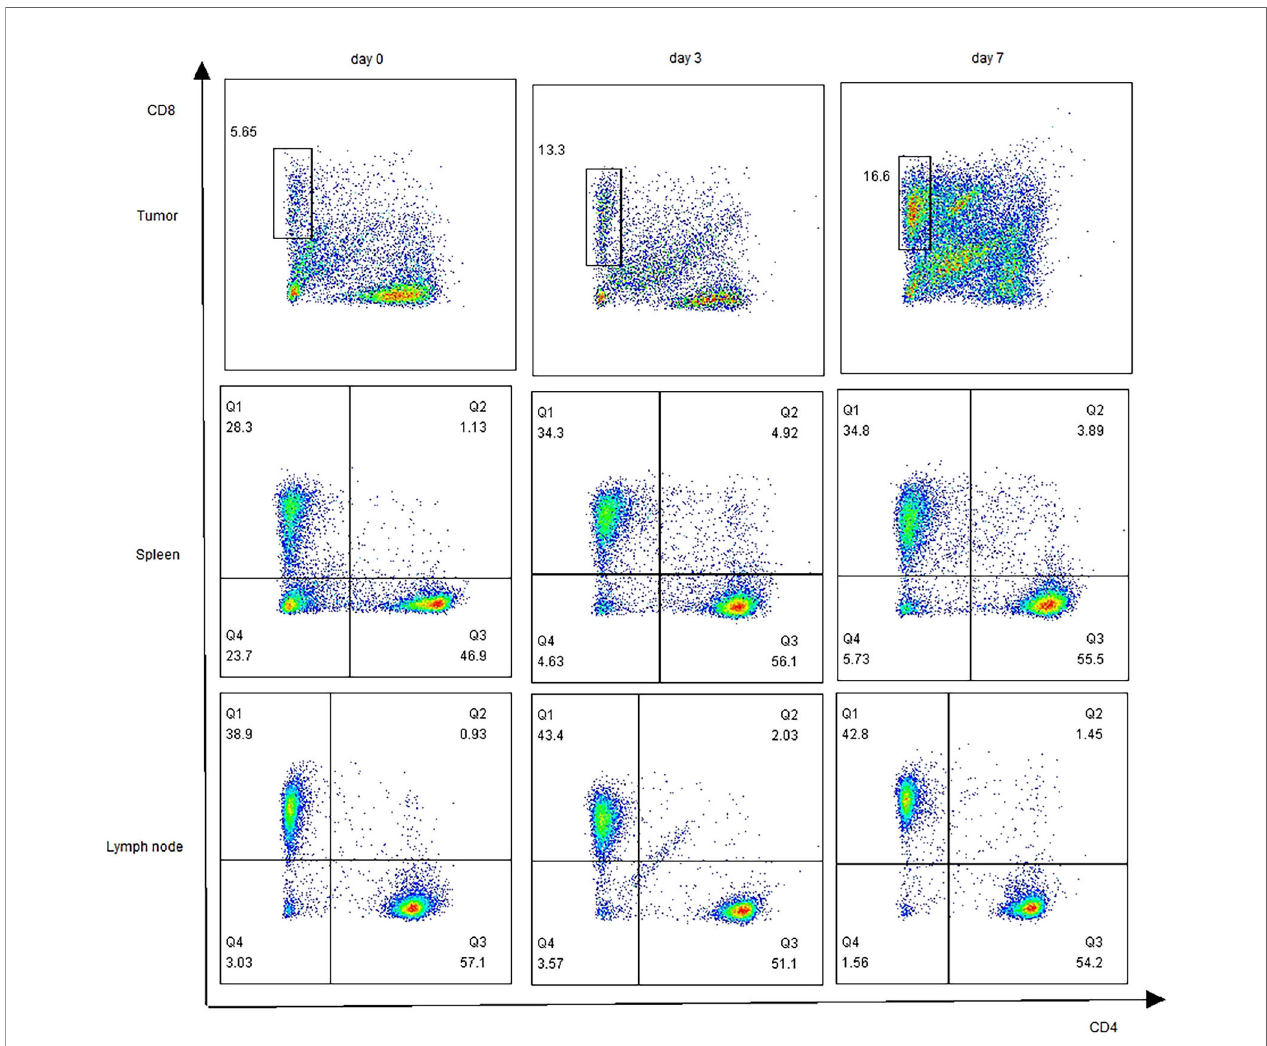
FIGURE 5 | Pro fi ling of T cells after nsPEFs treatment. The ratios of CD4 +/ CD3 + , CD8 + /CD3 + in response to nsPEFs treatment in the tumor tissue, spleen, and axillary lymph nodes on day 3 and 7. One representative fl ow cytometric graph for each pattern was shown here (n = 4). Data are presented as the mean ± SD. P-values were calculated based on a Student ’ s t-test (n = 4 per